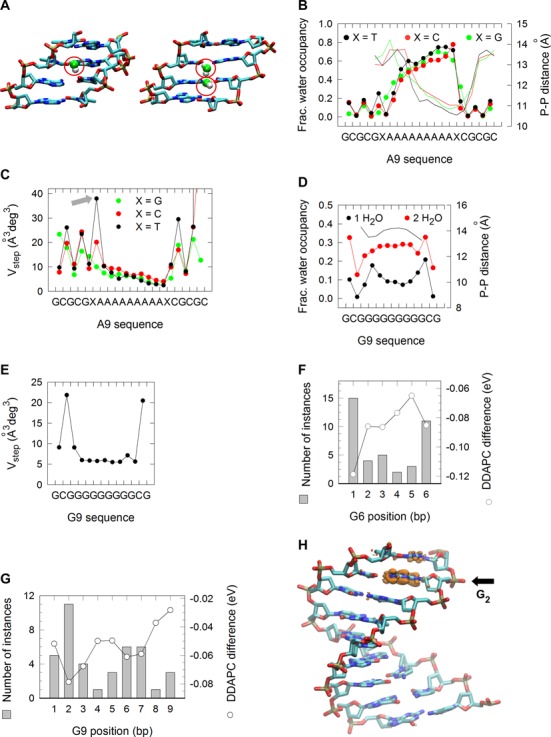
MD and QM/MM simulations. (A) Molecular modeling of one (left) and two (right) minor groove water bridge coordination. (B) Fraction of one-water bridge occupancy (left axis) at A[9] DNA sequences flanked 5′ and 3′ by a T (black circles), C (red circles) or G (green circles). Minor groove widths (right axis), as determined from intrastrand phosphate-to-phosphate distances. (C) Vstep for A[9] DNA sequences, determined as the product of the square root of the eigenvalues (λi) described by the six bp step parameters shift, slide, rise, tilt, roll and twist; i.e. \documentclass[12pt]{minimal}
\usepackage{amsmath}
\usepackage{wasysym}
\usepackage{amsfonts}
\usepackage{amssymb}
\usepackage{amsbsy}
\usepackage{upgreek}
\usepackage{mathrsfs}
\setlength{\oddsidemargin}{-69pt}
\begin{document}
}{}$V_{step} = \prod\nolimits_{i = 1}^6 {\sqrt {\lambda _i } }$\end{document}. (D) Fraction of one- (black circles) and two-water (red circles) bridge occupancy (left axis) at G[9] DNA sequences. Minor groove widths (right axis), as assessed from intrastrand phosphate-to-phosphate distances. (E) Vstep for G9 DNA sequences. (F) Average charge redistribution (open circles and right axis) for G[6] DNA structures upon vertical ionization, examined by calculating the difference on the density-derived atomic partial charges (DDAPC) for the neutral and negatively charged states. Histogram of the number of instances (left axis) in which the largest charge redistribution occurred at a specific position along the G[6] structures. (G) DDAPC for G[9] DNA structures (open circles and right axis) and histogram of the number of instances (left axis) in which the largest charge redistribution occurred at a specific position. (H) VMD rendering of a G[9] DNA structure displaying hole localization at G2. Capped base pairs were removed for clarity.